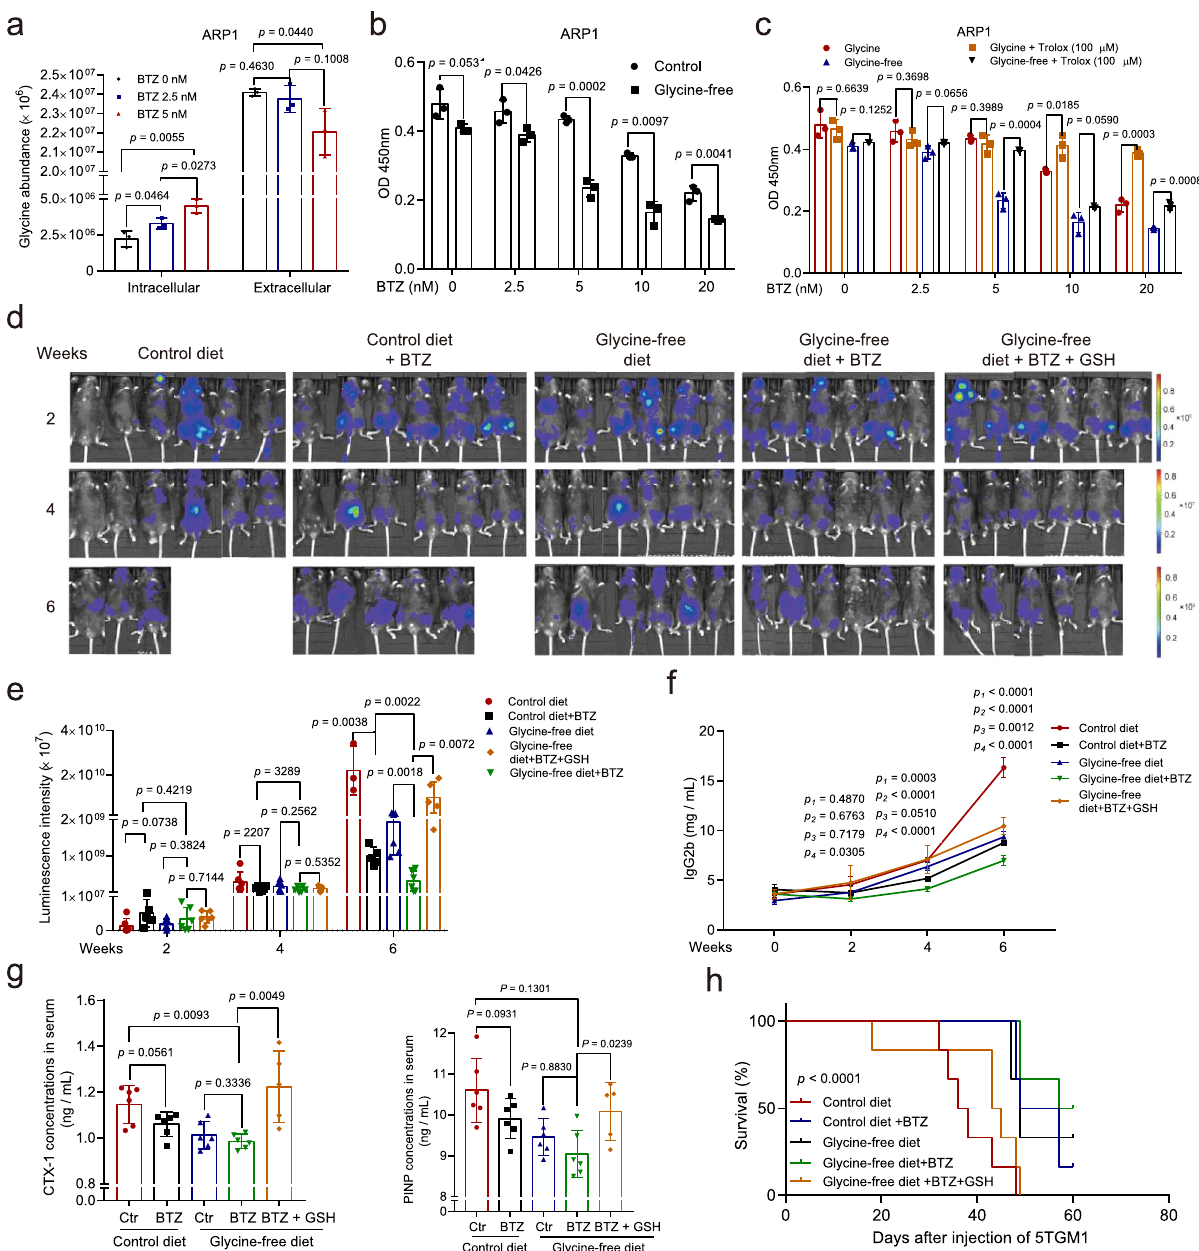
Fig. 5 Glycine deprivation sensitizes MM cells to BTZ. a Intracellular and extracellular glycine concentrations in ARP1 cells treated with different doses of BTZ (0, 2.5, or 5 nM) for 24 hr. b ARP1 cells cultured with (10 mg/L) or without exogenous glycine were treated with different doses of BTZ (0, 2.5, 5, 10, or 20 nM) for 48 h, followed by a CCK-8 assay. c ARP1 cells cultured with (10 mg/L) or without exogenous glycine were treated with different doses of BTZ (0, 2.5, 5, 10, or 20 nM) and with or without Trolox (100 μ M) for 48 hr, followed by a CCK-8 assay. n = 3 independent experiments; Results represent means ± SD; Signi fi cance was analyzed with an unpaired two-sided nonparametric t -test in ( a – c ). d Live imaging of tumor-associated luminescence intensity in 5TGM1 MM mice in the groups fed with the control diet ( n = 6 mice), fed with control diet and treated with BTZ (1 mg/kg, 3 times/week, n = 6 mice), fed with glycine-free diet ( n = 6 mice), fed with glycine-free diet and treated with BTZ (1 mg/kg, 3 times/week, n = 6 mice), or fed with glycine-free diet and treated with BTZ (1 mg/kg, 3 times/week) plus GSH (2 mg/kg, 3 times/week) ( n = 6 mice). e , f The luminescence intensities and serum IgG2b concentrations of the fi ve groups of 5TGM1 MM mice. g Quanti fi cation of bone resorption marker CTX-I and formation marker PINP. Results represent means ± SD; Signi fi cance was analyzed with an unpaired two-sided nonparametric t -test in e , f ( p 1 represent the signi fi cance between contro and control + BTZ, p 2 represent the signi fi cance between glycine-free and glycine-free + BTZ, p 3 represent the signi fi cance between control + BTZ and glycine-free + BTZ, p 4 represent the signi fi cance between glycine-free + BTZ and glycine-free + BTZ + GSH), g . h The survival curves of the fi ve groups of 5TGM1 MM mice (Log-rank test). Source data are provided as a Source Data fi